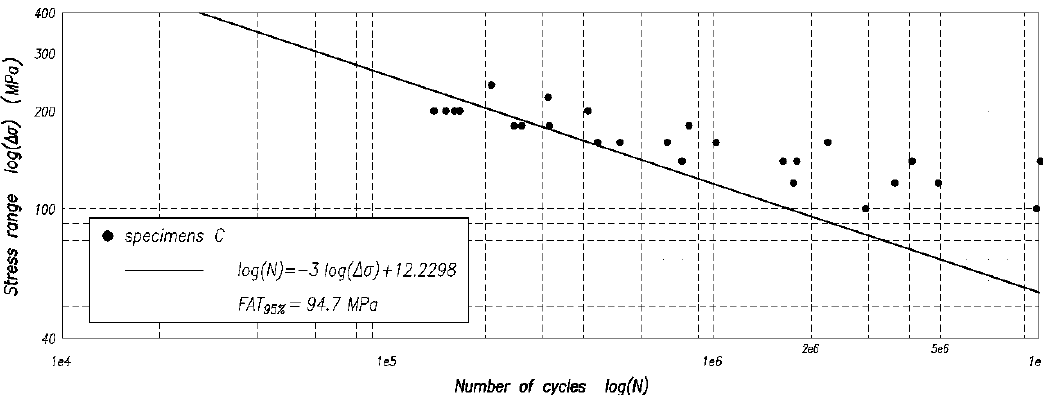
Figure 15. S-N curve with m = 3 for welded joints without defects (type-C specimens).